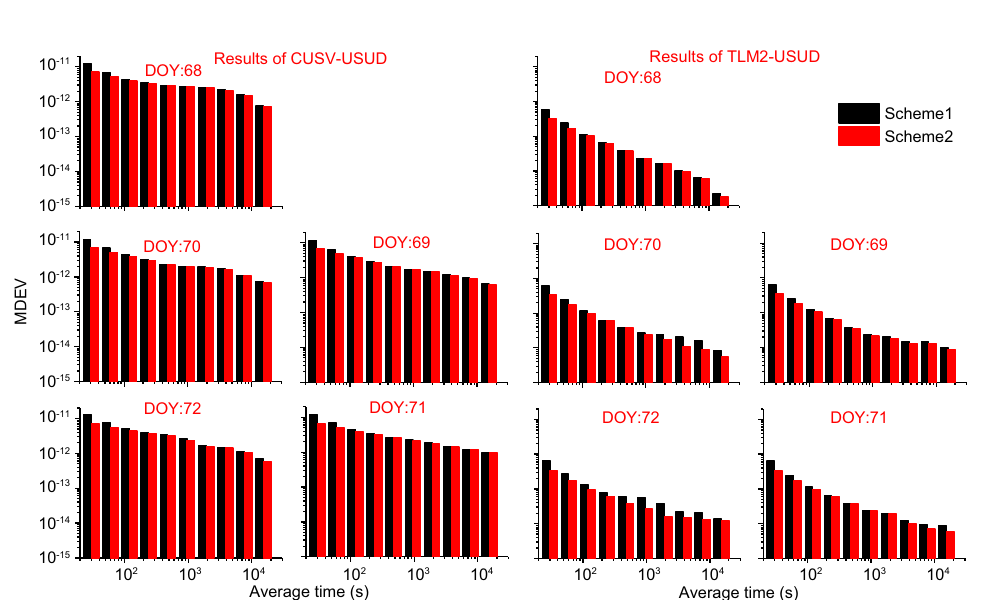
advantages: (1) BDS-3 or BDS-3/GPS PPP time transfer can reach accuracy at 0.1 ns level. The greatest improve- ment percentage is about 45.0% and 38.9% for BDS-3 and BDS-3/GPS PPP, respectively; (2) the clock model can avoid a need for solution re-convergence when data is abnormal; (3) the clock model can significantly improve the short-term stability by up to 57.4%, but less for the long-term stability; (4) Both the long- and short-term frequency stability are much improved when there exist abnormal data.